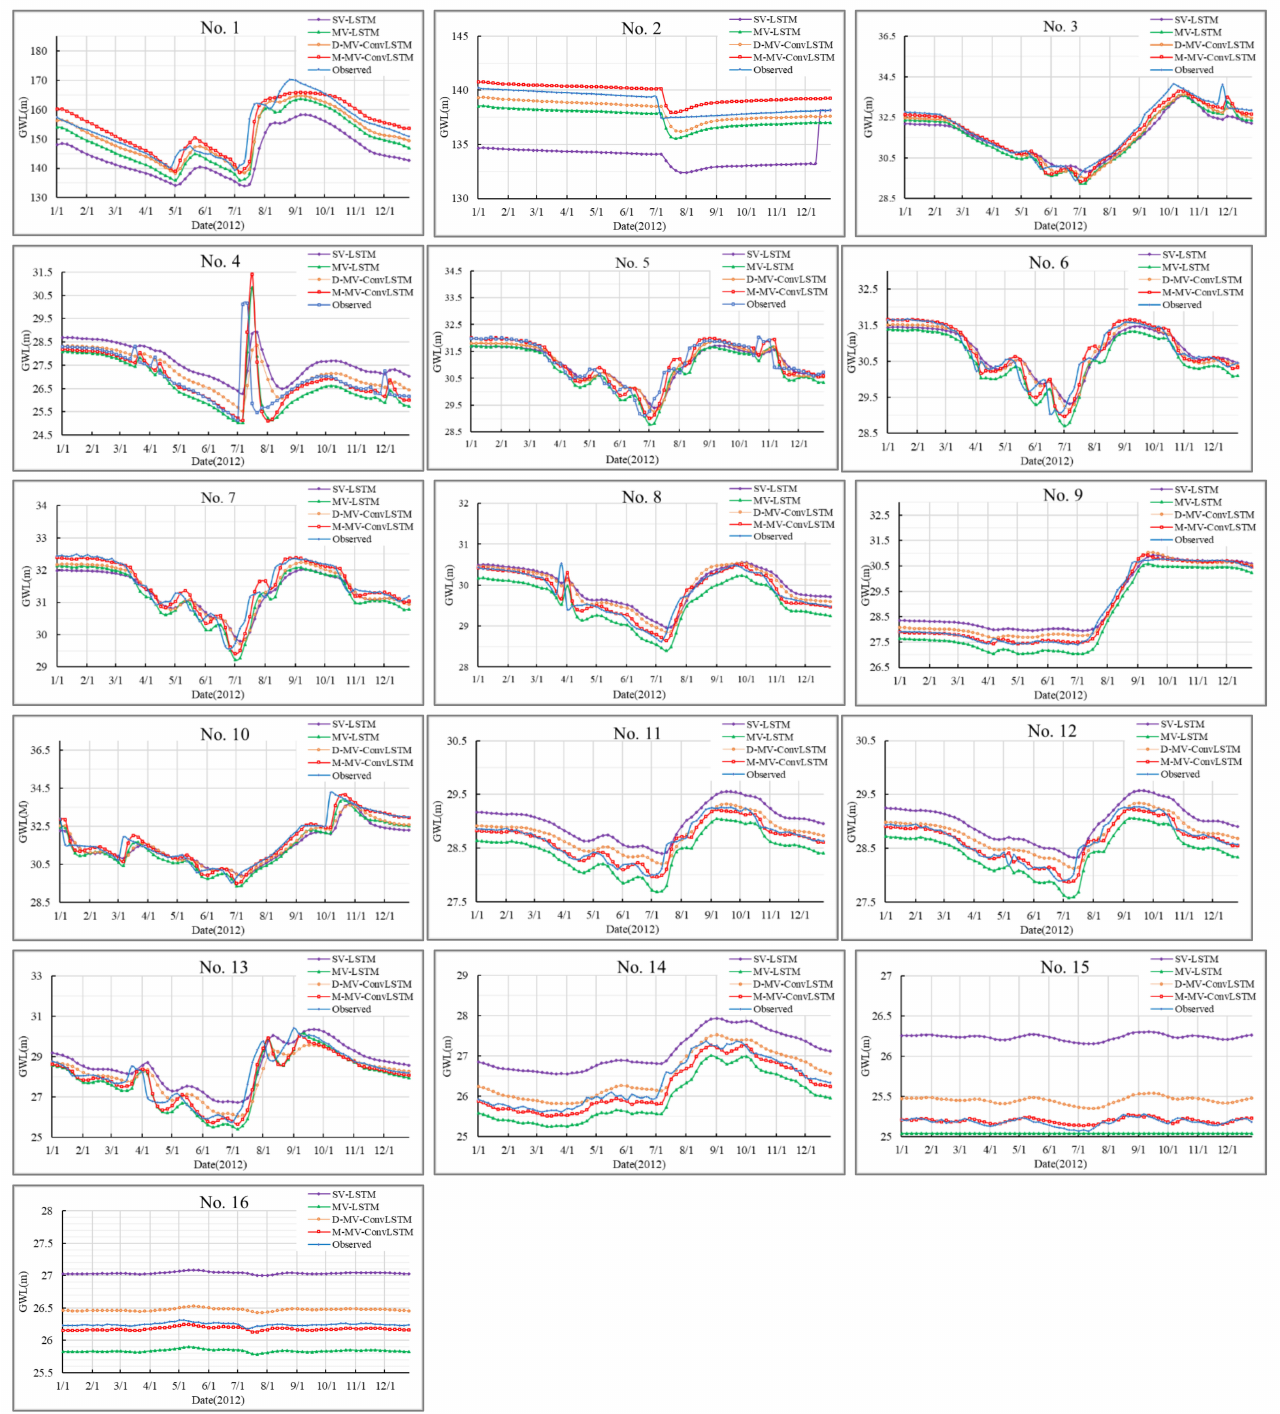
Figure A1. Modeling simulation results obtained at all wells in the four